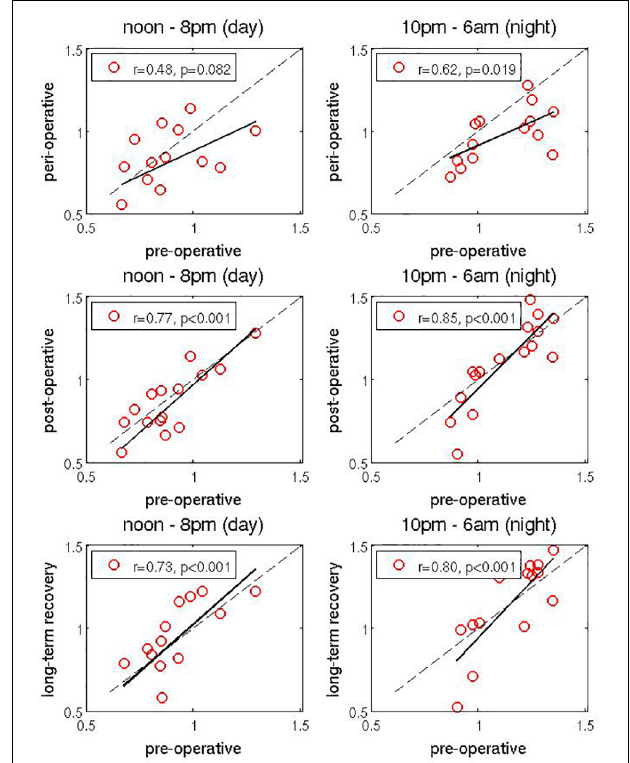
FIGURE 3 | Scatter plots of vagal activity values. Peri-operative values (top panels) , post-operative values (middle panels) , and long-term recovery values (bottom panels) are reported on the vertical axis, as a function of pre-operative values, which are in all panels reported on horizontal axis (each dot represents one patient). They are computed, respectively, as values on T3, average between T4 and T5, average between T9 and T10, average between T1 and T2. Changes in day-time values (measured from noon to 8 pm) are shown on the left and changes in the night-time values (measured from 10 pm to 6 am) are shown on the right. Linear regression is shown as a full black line and the line of identity is shown as a dashed black line. Correlation coefficient r is reported for each plot separately. Significances are all p < 0.08. While the event of surgery clearly reduces the vagal activity, the rehabilitation process gradually restores it to the original values. In fact, in some cases final vagal activity values are actually higher than the original pre-operative values. This effect is especially pronounced during the night (due to logarithmic representation of vagal activity values, real changes are actually more pronounced than it appears). See text and Table 2 . Figures have different numbers of points, since for 16 patients that completed the study certain daily and/or nightly values are